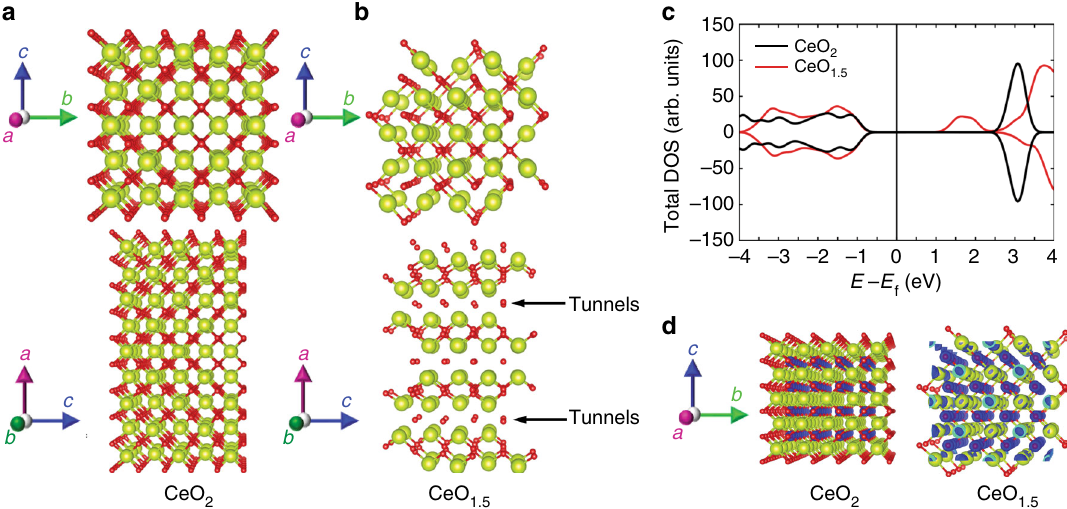
Fig. 4 First-principles calculations performed on stoichiometric CeO 2 and non-stoichiometric CeO 1.5 . a Structural projections along the [100] and [110] directions for stoichiometric CeO 2 . b Structural projections along the [100] and [110] directions for non-stoichiometric CeO 1.5 , where the V (cid:1)(cid:1) O are self- organised into clustered one-dimensional tunnels oriented in the [001] direction. c Effect of ½ V (cid:1)(cid:1) O (cid:3) on calculated spin-polarised total density of electronic states, showing spin-up (positive) and spin-down (negative) regions (Fermi energy levels shifted to zero). d Structural projections along the [100] direction for stoichiometric CeO 2 and non-stoichiometric CeO 1.5 ; surfaces of identical electronic charge are highlighted with blue colour; the electronic density increases around the Ce ions, which are located near the oxygen vacancies, compared to the stoichiometric system. Large yellow and small red spheres represent Ce and O ions, respectively